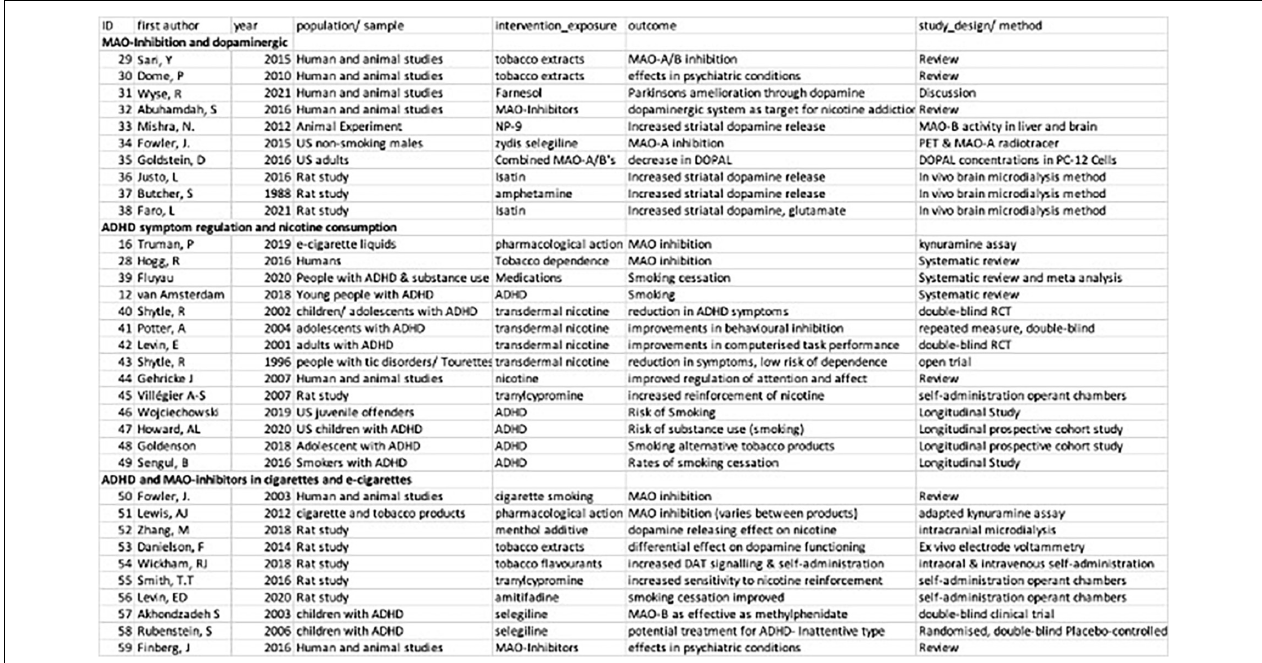
FIGURE 2 | Summary of studies included in scoping review of MAOI- related self-medication models of ADHD and